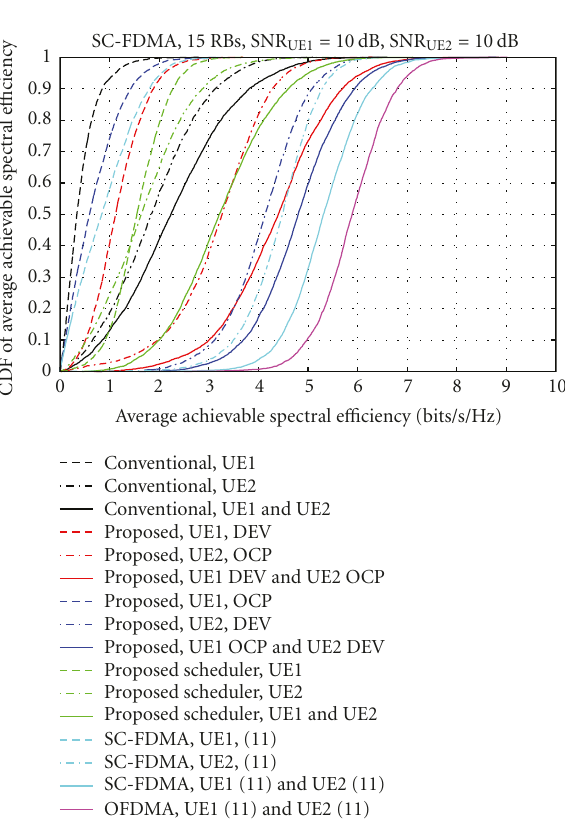
Figure 7: Parameter setting is the same with Figure 6 but 100RBs are available in the system.